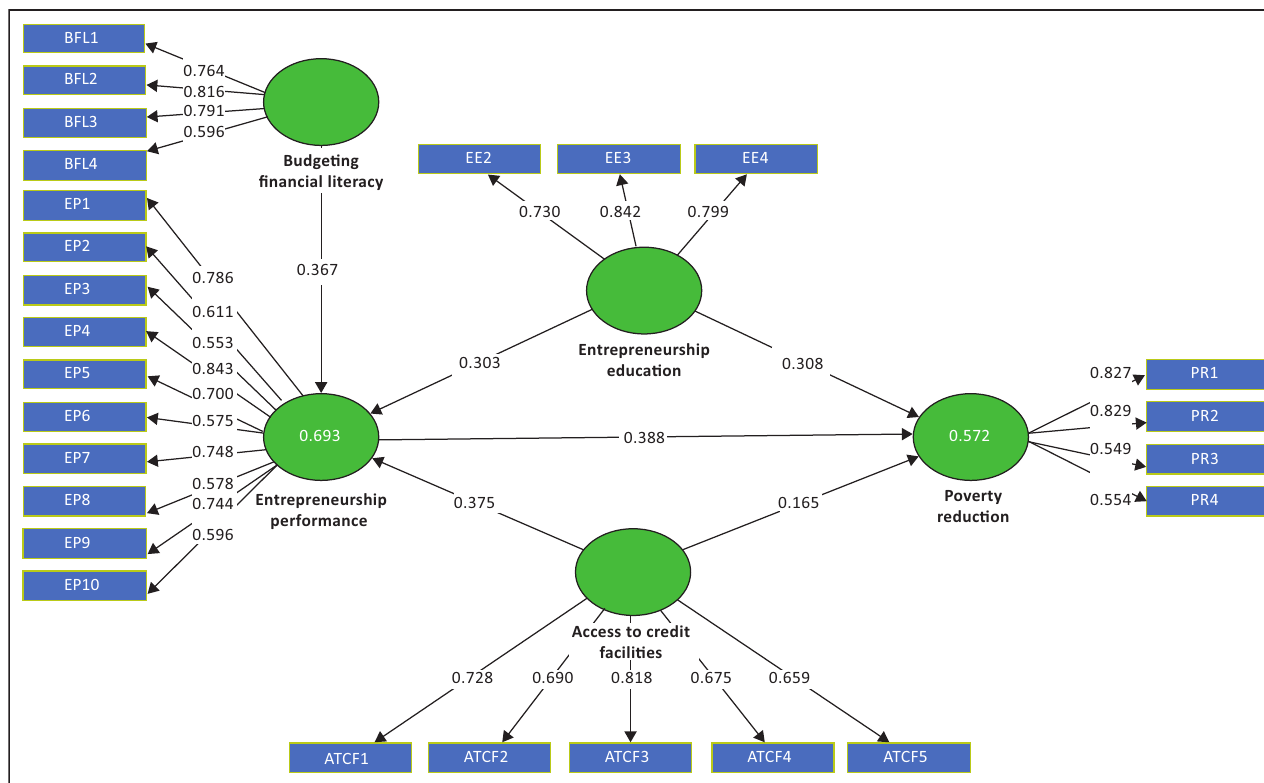
FIGURE 3: Measurement and structural model TABLE 3: Results of structural equation model analysis. Hypothesis Causal path